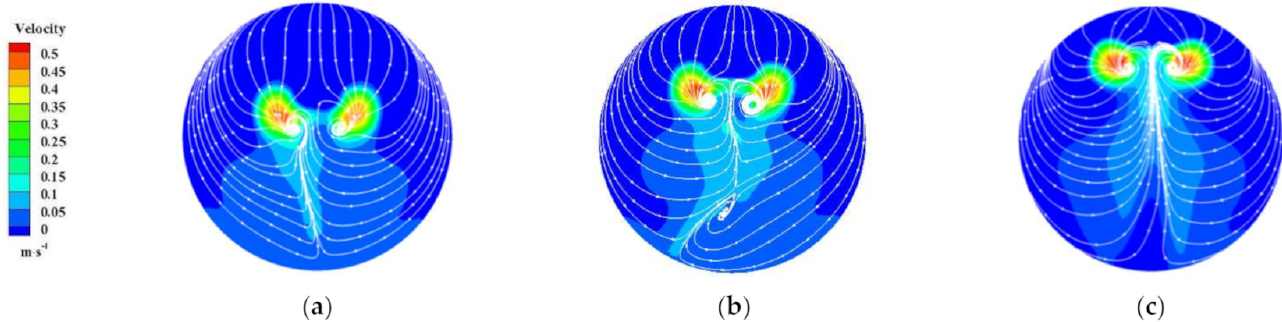
Figure 7. Streamline and velocity distribution nephogram of Section 3-3 under different L values: (a) L = 0.2 R ; (b) L = 0.4 R ; (c) L = 0.6 R.